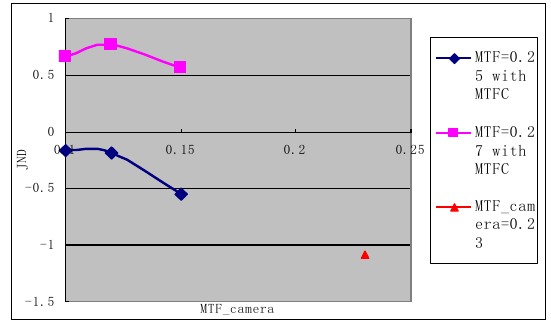
Figure 5. Group B post-processing validation Conclusions can be validated in two groups as Figure 4 and Figure 5 illustrated: 1. Image quality with post-processing is better than without post-processing 2. Image quality is equivalent between camera MTF=0.1